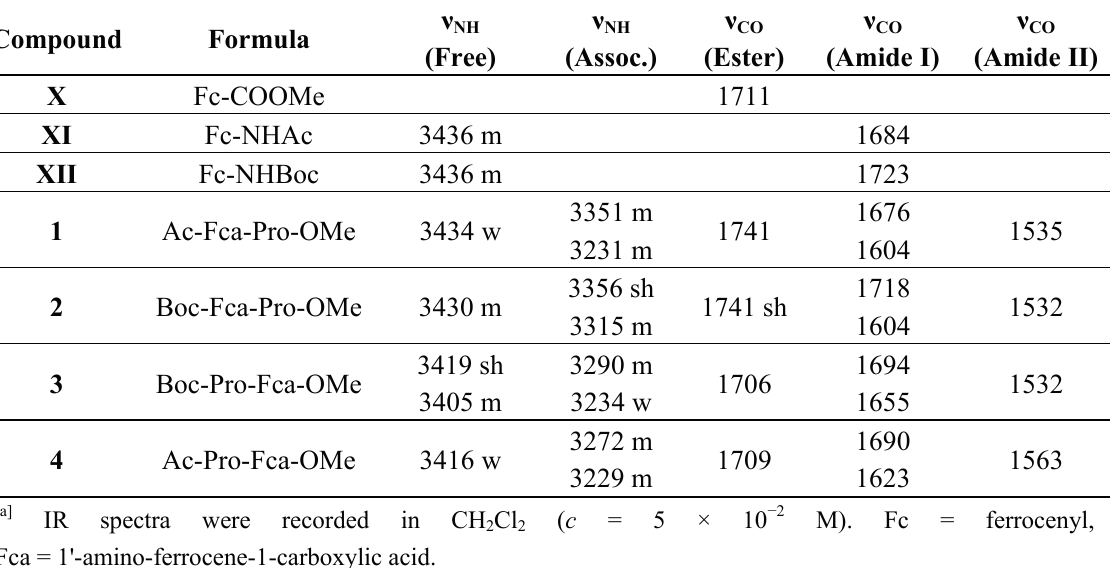
Table 3. IR spectroscopic data [a] (cm − 1 ) of reference ( X – XII ) and goal compounds 1 – 4 .